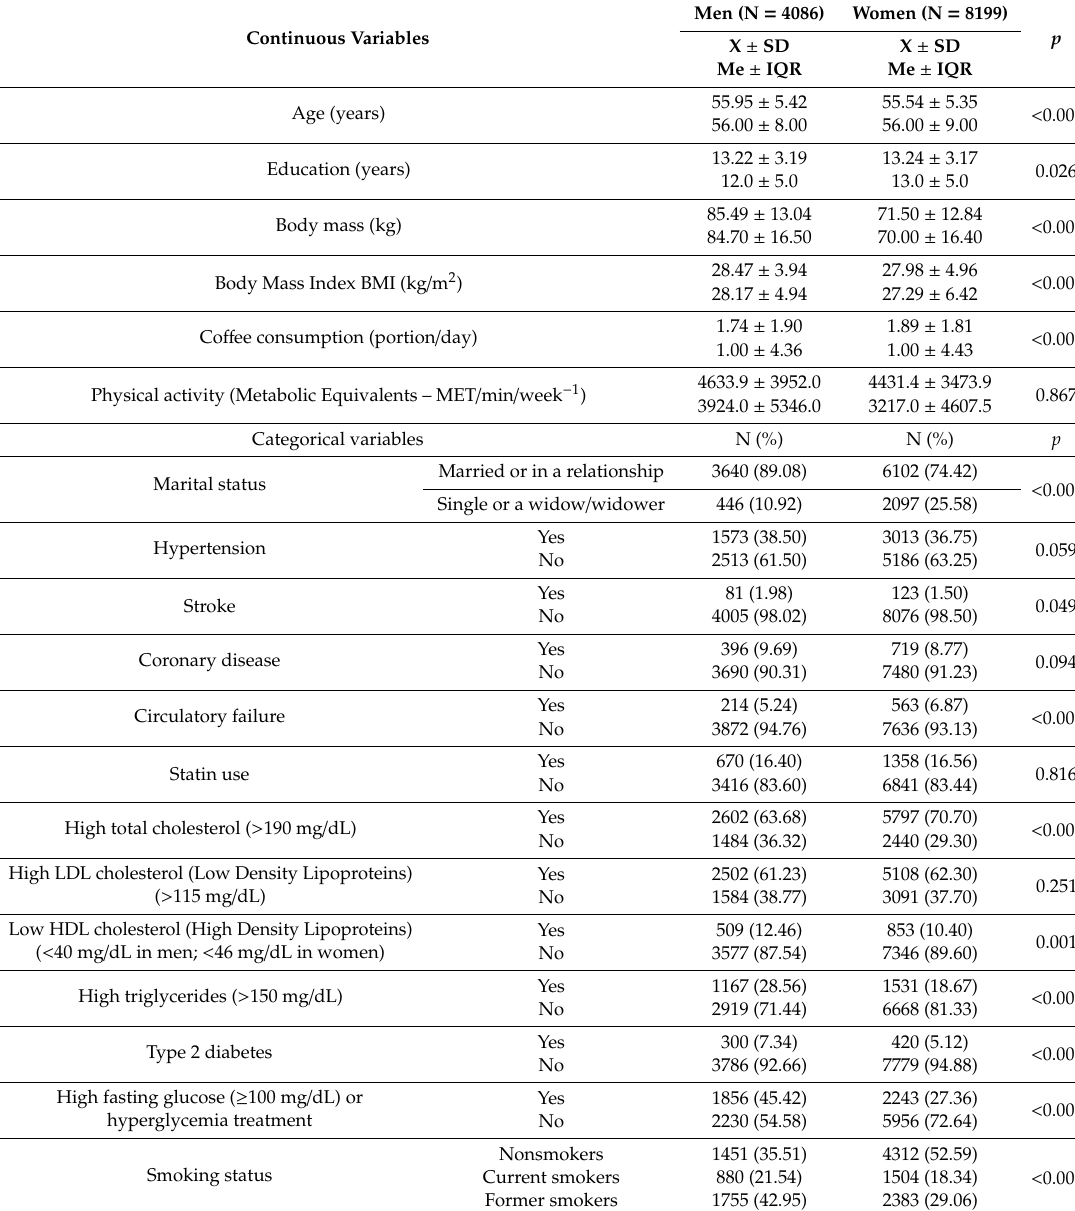
Table 1. Sociodemographic characteristics and lifestyle habits of the subject